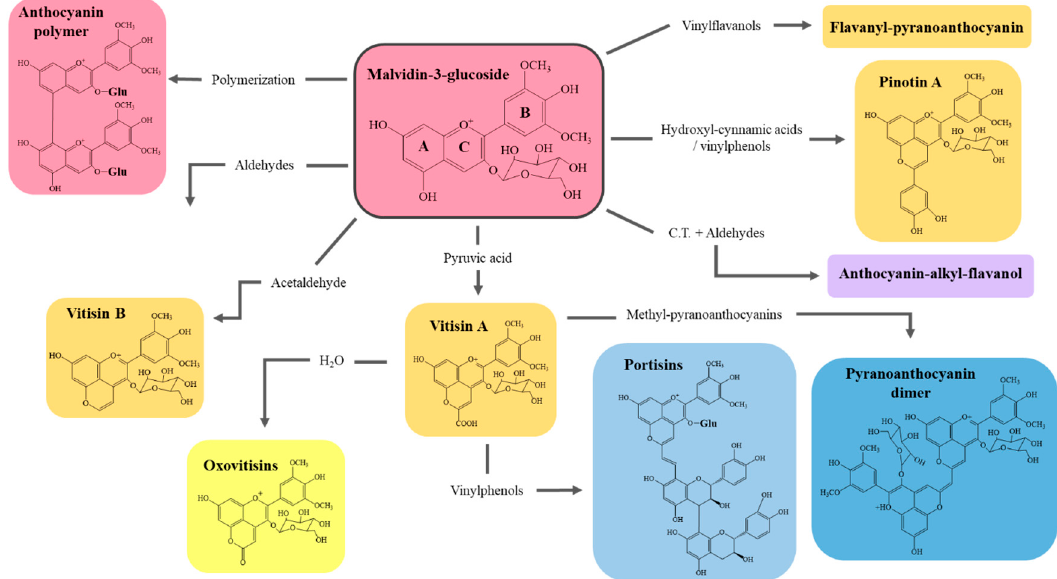
Figure 3. Overview of the general structure of anthocyanins and formation of pyroanthocyanins, representing their coloration in wine acidic medium. C.T.: Condensed tannins. Adapted [113,114].